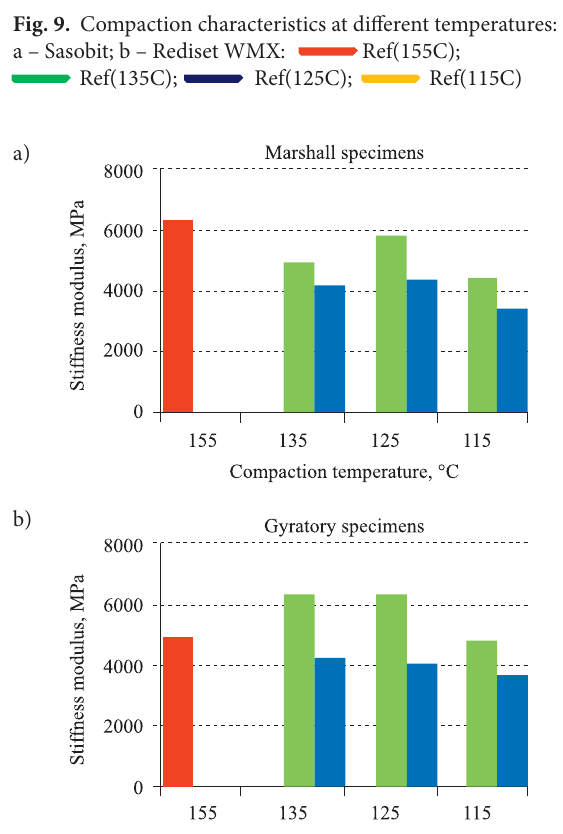
Fig. 10. Stiffness modulus test results: a – Marshall specimens;